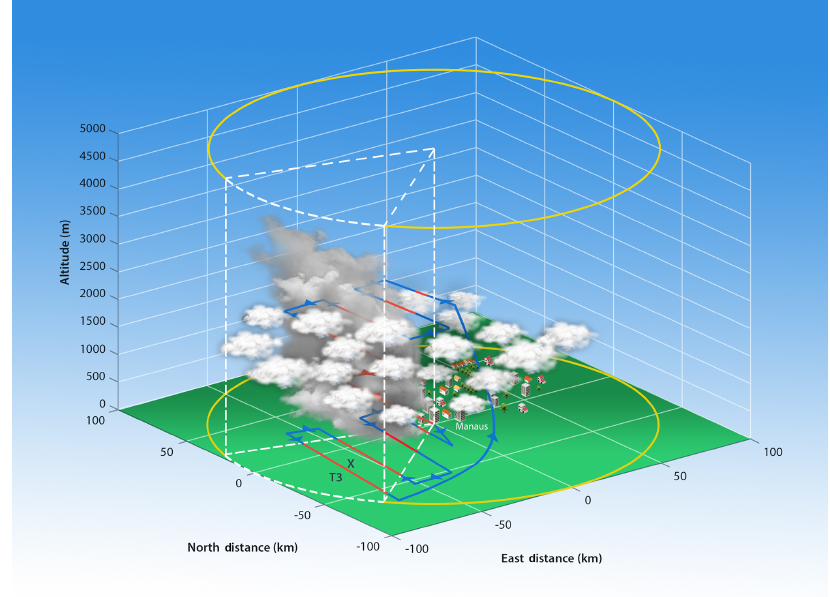
Figure 1. Conceptual schematic for the flight patterns planning. It shows Manaus city and its pollution plume dispersing over the surrounding Amazon forest. The Cu field shown is very common during the wet season and is representative for most of the cloud conditions during the flights. The yellow circles indicate a 100km radius from Manaus airport, although the figure is not meant to be quantitatively accurate. The lines with arrow heads show the most common flight plan used, where blue regions are possible locations for the background air measurements and the red ones indicate measurements inside the plume section (dashed white lines). T3 is a GoAmazon site to the north of Manacapuru.